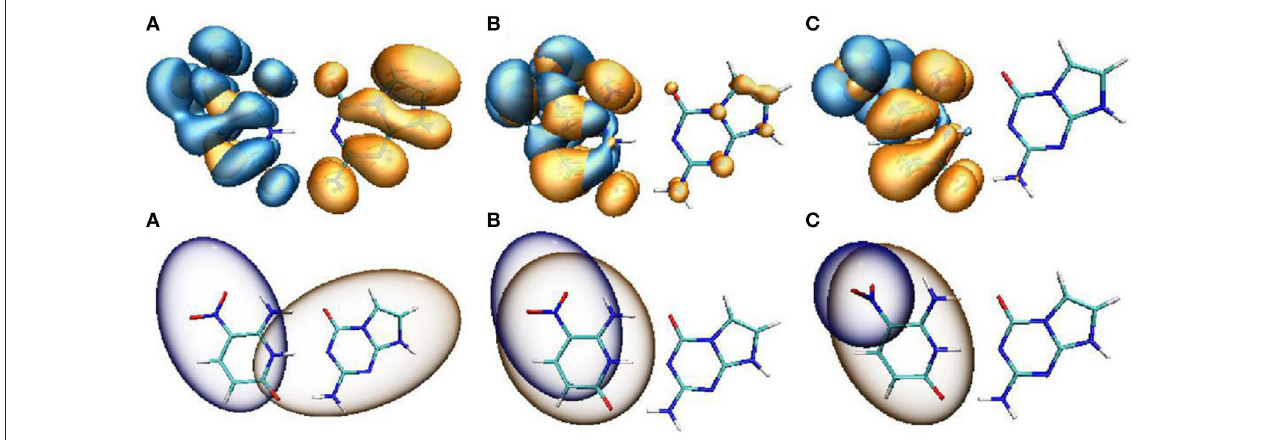
FIGURE 5 | Hole-electron distribution (upper panel) and the C hole -C ele diagrams (lower panel) of ZP with the rotational displacements of 0 ◦ (A) , 45 ◦ (B) , 90 ◦ (C) . Orange and blue regions (isovalue = 0.0002) denote the electron distributions and the holes,